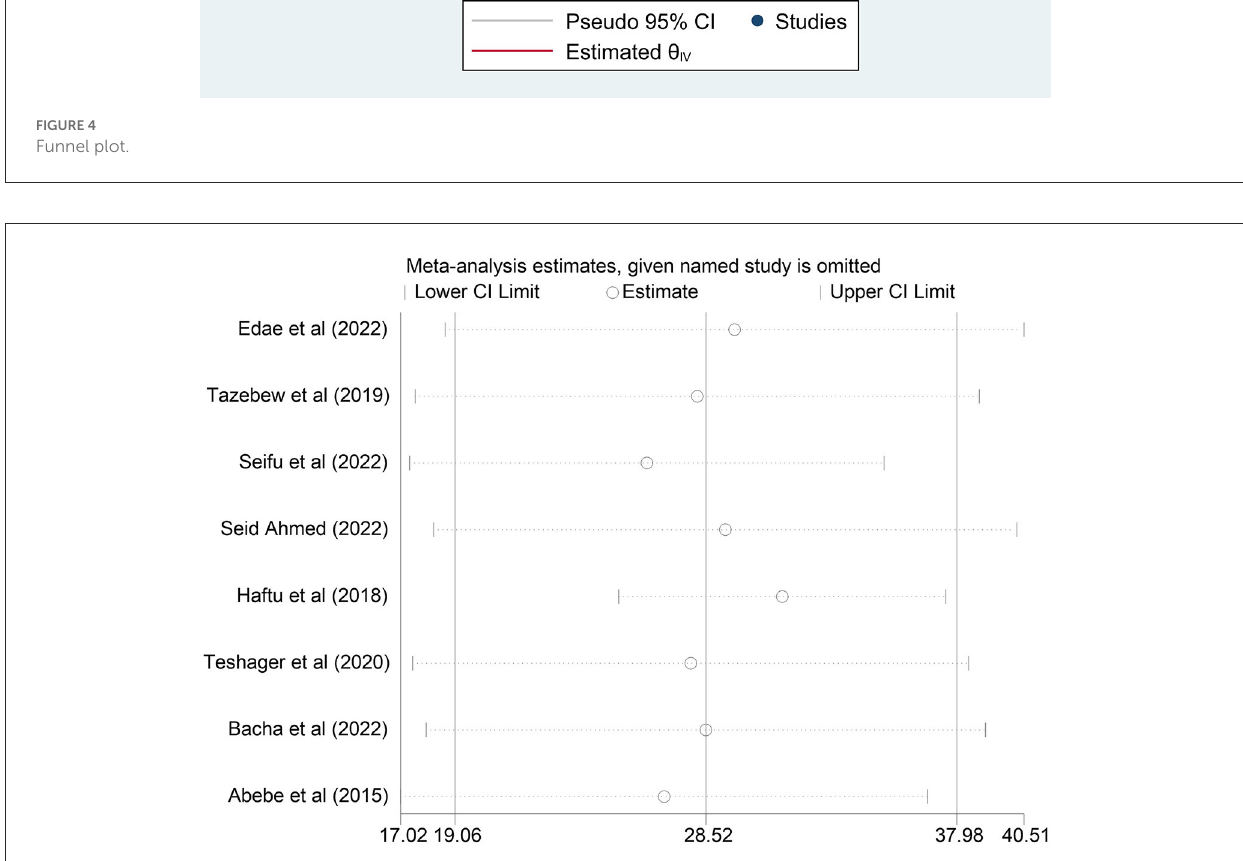
FIGURE5 Sensitivity